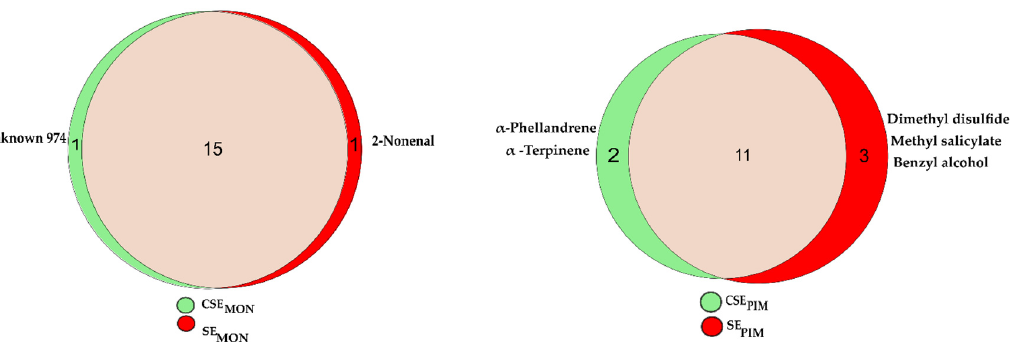
Figure 3. Qualitative overview of root volatiles present uniquely in stressed (SE), control plants (CSE) or in both. Each Euler plot (left S. lycopersicum Moneymaker (MON), right S. pimpinellifolium (PIM)) shows the stress-related compounds in red as SE MON and SE PIM respectively, in the beige intersection the common compound found in both treatments and in green as CSE MON and CSE PIM respectively the nonstress related compounds.